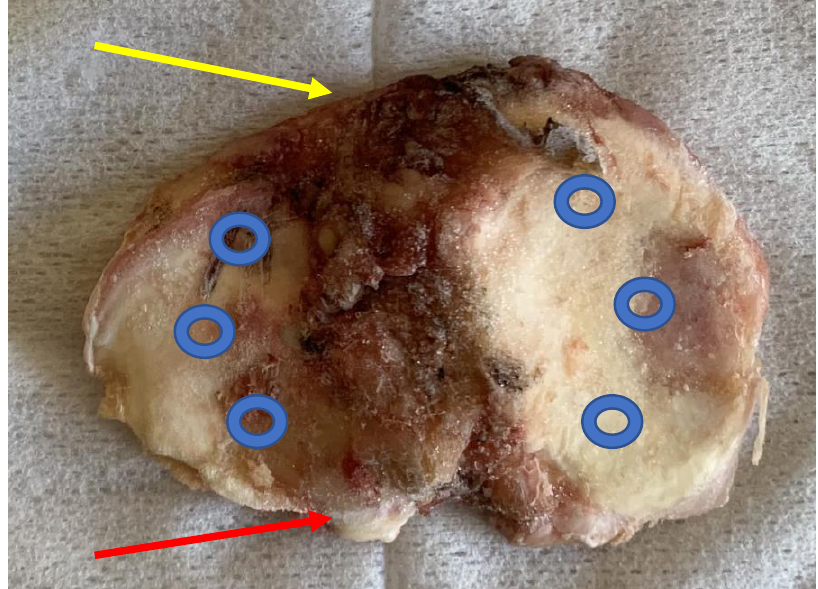
Figure 5. Prepared tibial condyle. Yellow arrow — anterior part of the condyle; red arrow — posterior part of the condyle. Blue rings — places of the bone blocks collection. Source: proprietary material.